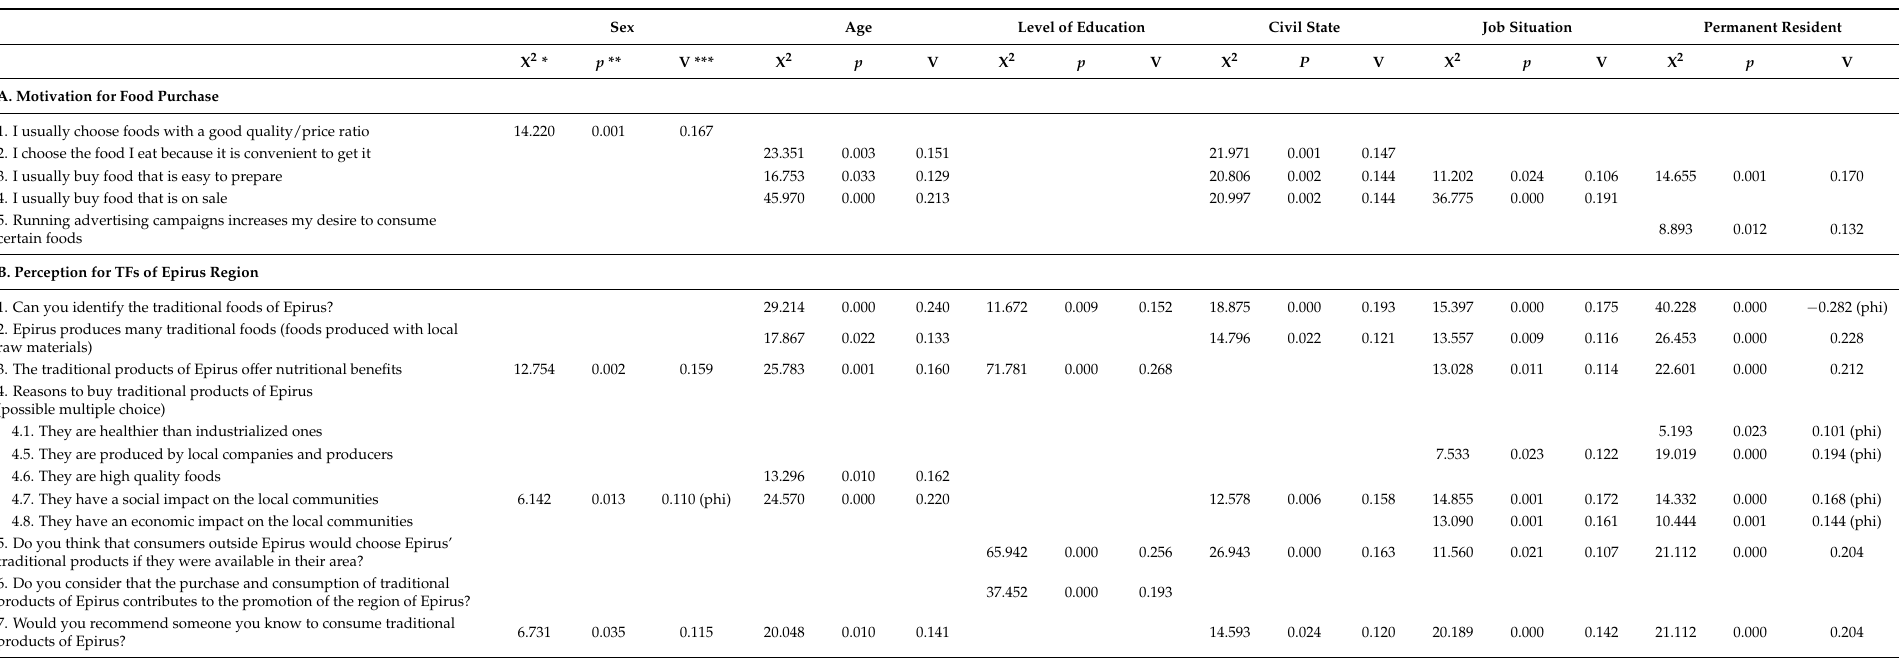
Table 3. Associations between variables (A) value motivation for food purchase, (B) value perception for TFs of the Epirus region and the sociodemographic variables. Sex Age LevelofEducation CivilState JobSituation